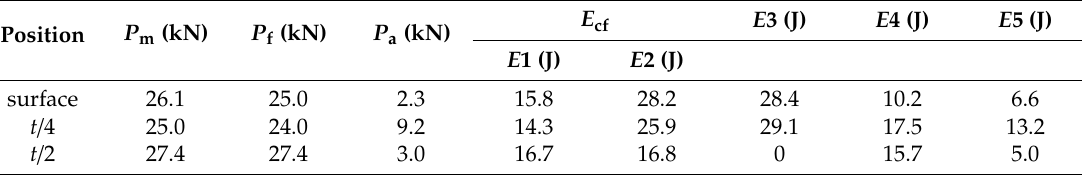
Figure 9. Curves of load and Charpy V-notch energies (CVN) vs. displacement obtained from the instrumented impact testing at − 60 ◦ C. ( a ) sub-surface, ( b ) t / 4, ( c ) t / 2. Table 3. Experiment data from instrumented Charpy impact tests.